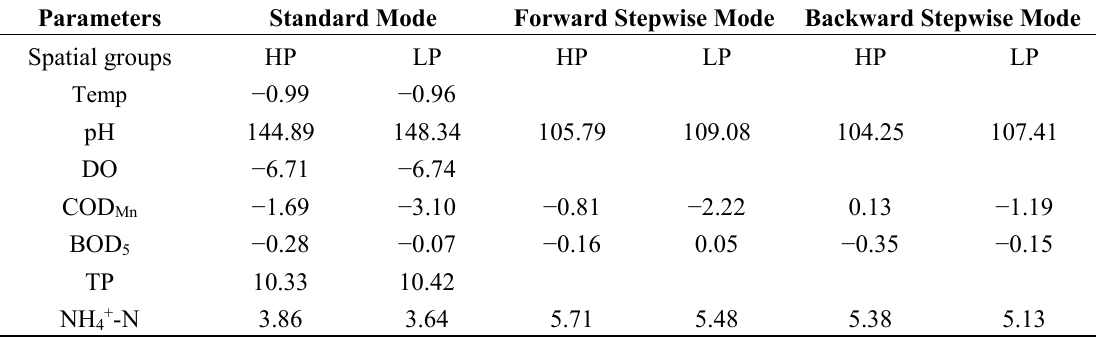
Table 5. Classification functions’ coefficients for discriminant analysis of spatial and temporal